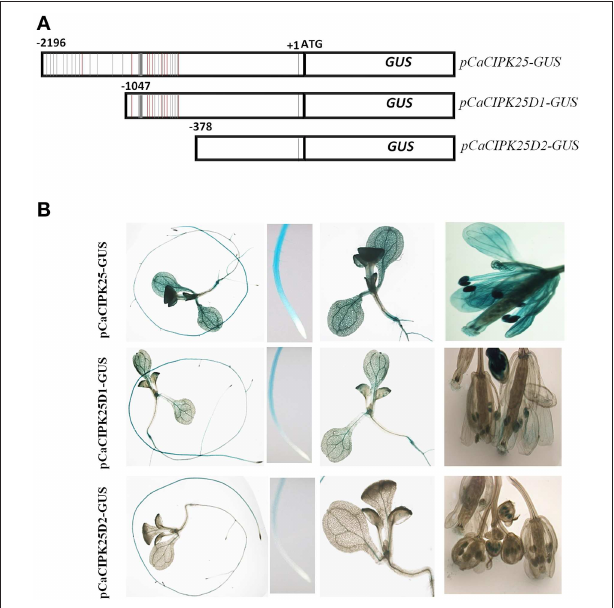
FIGURE 4 | Analysis of CaCIPK25 promoter for tissue-specific expression. (A) Schematic diagram of CaCIPK25 promoter-GUS reporter construct ( pCaCIPK25-GUS ) and its two truncated versions ( pCaCIPK25D1-GUS and pCaCIPK25D2-GUS ). Positions (not to scale) of ROOTMOTIFTAPOX1 and POLLEN1LELAT52 elements are shown in gray and red lines. Transcription and translation start sites ( + 1 and ATG) are marked. (B) Expression of GUS driven by different deletion constructs of CaCIPK25 promoters in whole seedlings, root apex, cotyledon, and leaves and flowers are